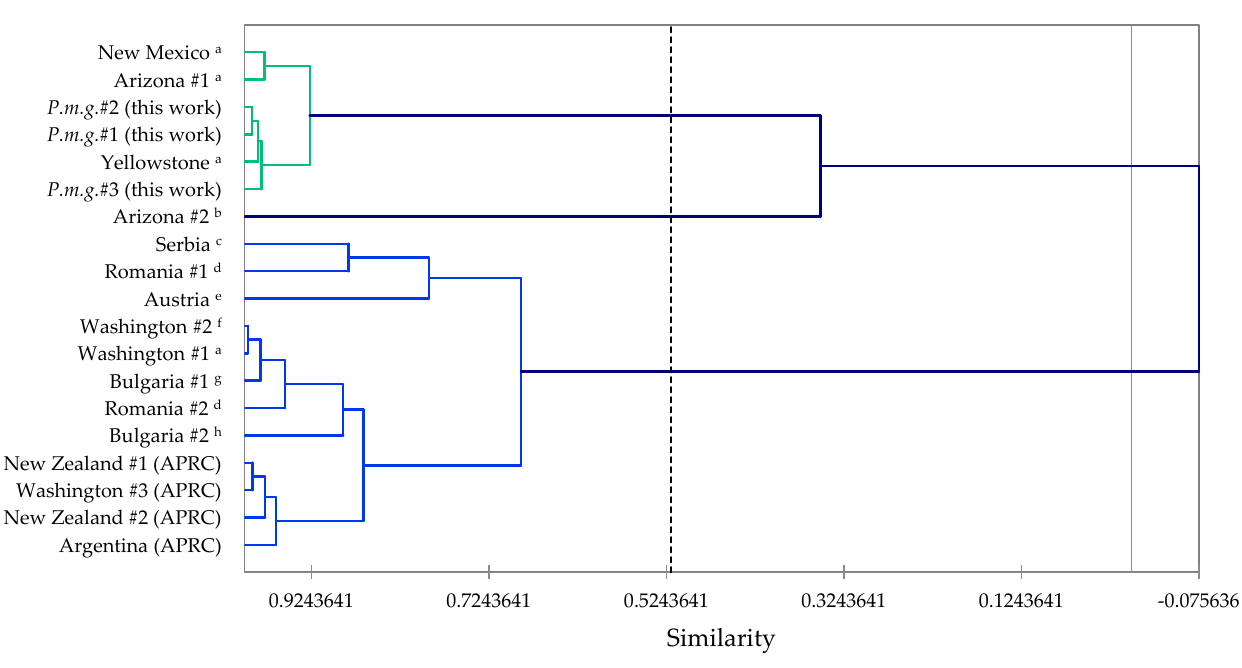
Figure 13. Dendrogram based on hierarchical cluster analysis of Pseudotsuga menziesii chemical compositions. P.m.g. = Pseudotsuga menziesii var. glauca . APRC = Commercial essential oil samples from the Aromatic Plant Research Center collection. a Von Rudloff, 1973 [16]. b Wagner et al., 1989 [31]. c Miti ć et al., 2021 [39]. d P ă dure et al., 2008 [38]. e Buchbauer et al., 1994 [35]. f Adams, 2012 [34]. g Jirovetz et al., 2000 [36]. h Jirovetz et al., 2000 [37].